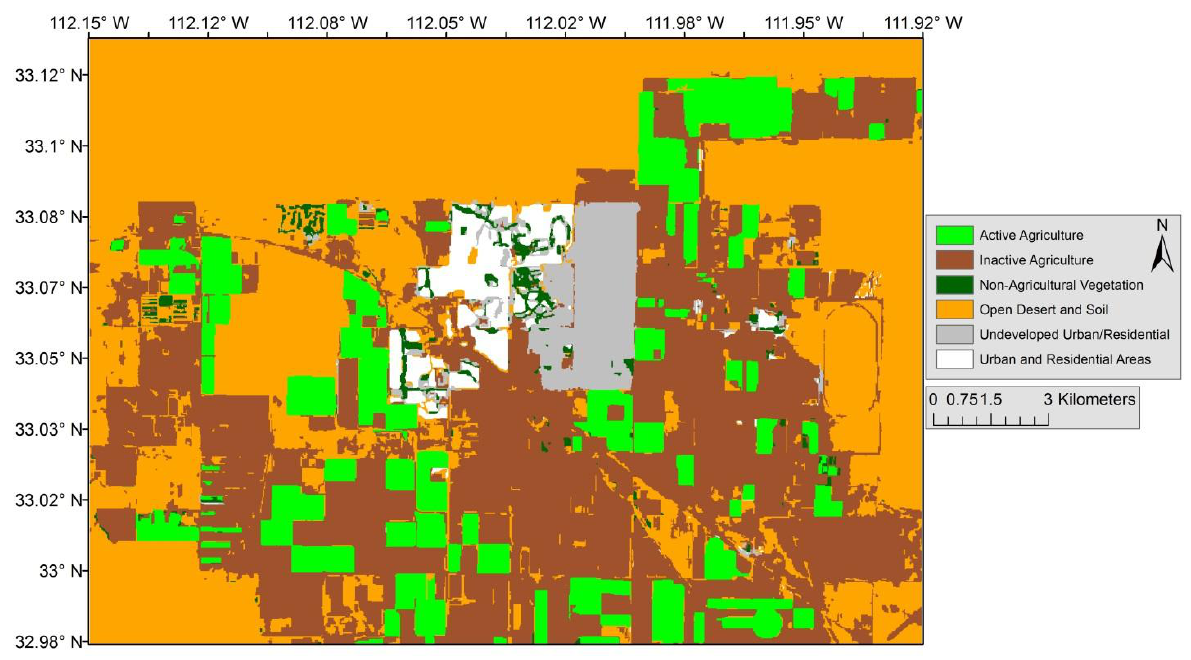
Figure 10. The OBIA land-use